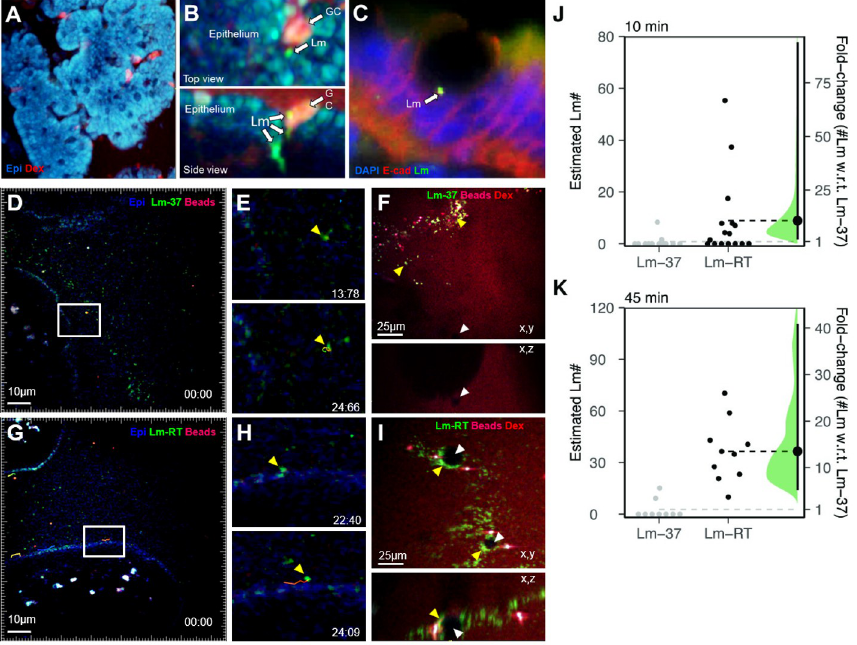
Fig 3. Lm wt interaction dynamics with human intestinal epithelium. A,B: human intestinal resection specimens were challenged with Lm Wt (green) and imaged with two-photon microscopy. A: autofluorescence of epithelial cells (blue) excited at 820nm. Several secreting goblet cells have been labeled by Rh-dextran (red) uptake. B: Lm-RT (green) can be seen binding to GCs and crossing the epithelium. C: Lm-RT (green) binding to E-cadherin (red) near a GC. Epithelial cell nuclei stained with DAPI (blue). D,E: human intestinal resection specimens were challenged with Lm and imaged with time-lapse two-photon microscopy. D: Lm-37 localizes predominately in the mucus layer identified by fluorescent beads (red) above the epithelium (blue, autofluorescence), with E: zoomed in views from a time-lapse sequence showing a Lm-37 track (time encoded). F: Lm-37 rarely attaches to the epithelium and fails to accumulate around GCs 45mpi. G: Lm-RT is often seen penetrating the mucus and scanning along the epithelium, with H: zoomed in views from a time-lapse sequence with an example track showing Lm-RT scanning the epithelium. Time stamp = min:sec. I: Lm-RT (green) attaches to the epithelium and accumulates around goblet cells (dark shadows) forming “rings”. Lm invasion efficiency with Lm-37 and Lm-RT was assessed at J: 10mpi and K: 45mpi. Invasion was significantly higher for motile Lm-RT (fold-change w.r.t. Lm-37 was 11 at 10 mpi and 14 at 45 mpi, with 95% CIs [2.1– 94] and [5.1–41], respectively). Bootstrapped fold-changes displayed as in Fig 2H and 2I; each point represents an image from at least 3 independent mice per